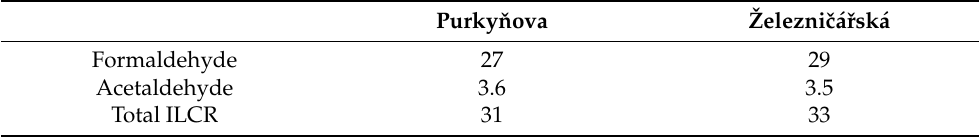
Table 12. Individual lifetime cancer risk ( × 10 6 ) of inhabitants of Stˇrekov- Ú st í nad Labem 1